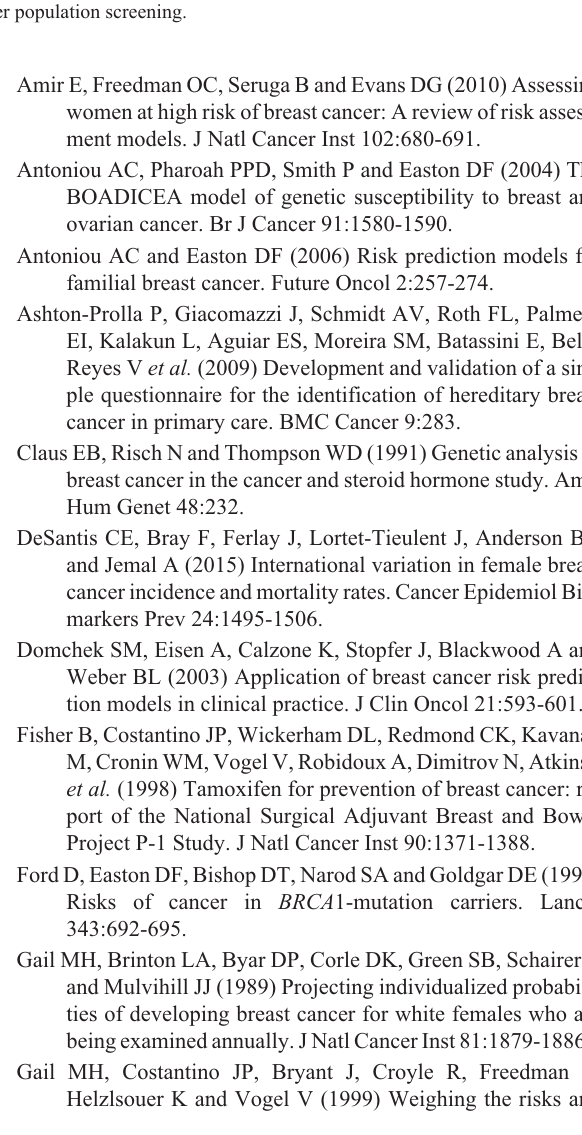
Figure2 -Astrategyforbreastcancerriskassessmentinprimarycarebasedonfamilyhistoryscreening . 1:AssuggestedbytheNationalComprehensive Cancer Network (NCCN) Guidelines 1.2015, Breast Cancer Screening and Diagnosis (NCCN, 2015). 2: As suggested by Saslow et al. (2007), Pruthi et al. (2015), and NCCN, 2015. 3: According to local policies for breast cancer population